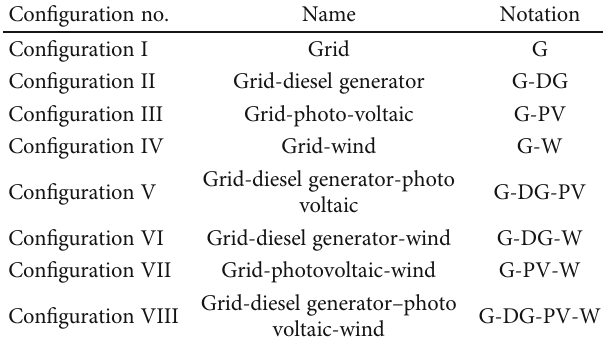
Table 2: Con fi guration